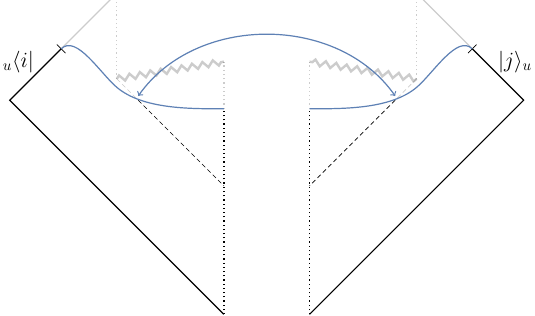
Figure 9. The saddle-point spacetime for computing the density matrix of an evaporating black hole. The future of the blue slice Σ u where the identification occurs is not part of the configuration, so the spacetime is weakly curved everywhere, and in particular excludes the